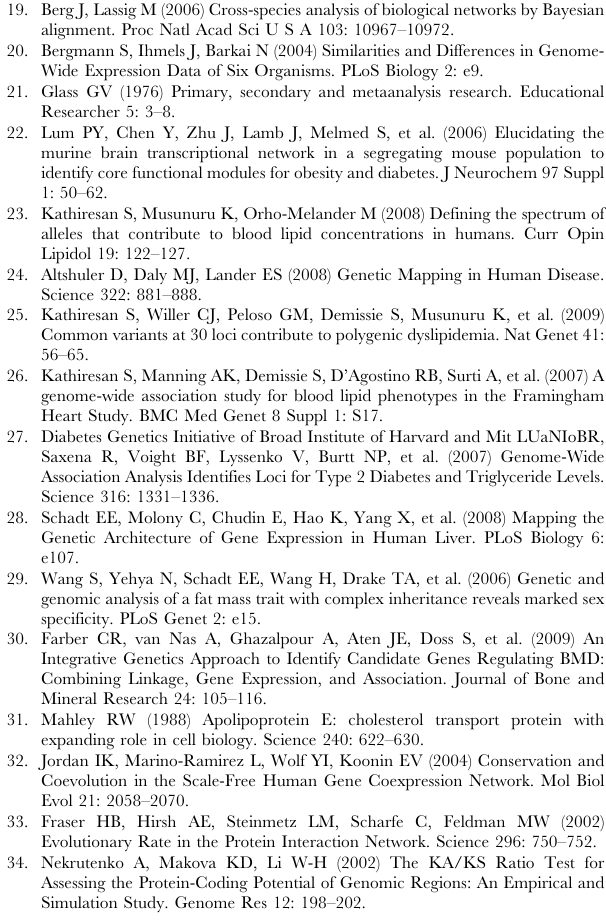
Table S11 Comparison of annotations for GWAS candidate genes based on the conserved modules or human modules. The annotation based on conserved module agrees better with the annotation based on the gene’s Gene Ontology annotation. Table S12 Enrichment of lipid-associating genes among ortho- logous genes between human and rodents. Lipid-associating genes are selected at different window size around a lipid-associating loci in Framingham and Broad studies. Table S13 List of 395 candidate lipid-associating genes by integrating GWA results, cis eSNP and conserved co-expression modules. RefSeq IDs, symbols and chromosomal location for each gene are shown in the table. Table S14 Top 20 genes with the most human-specific co- expression interactions. The numbers of interactions among themselves are also